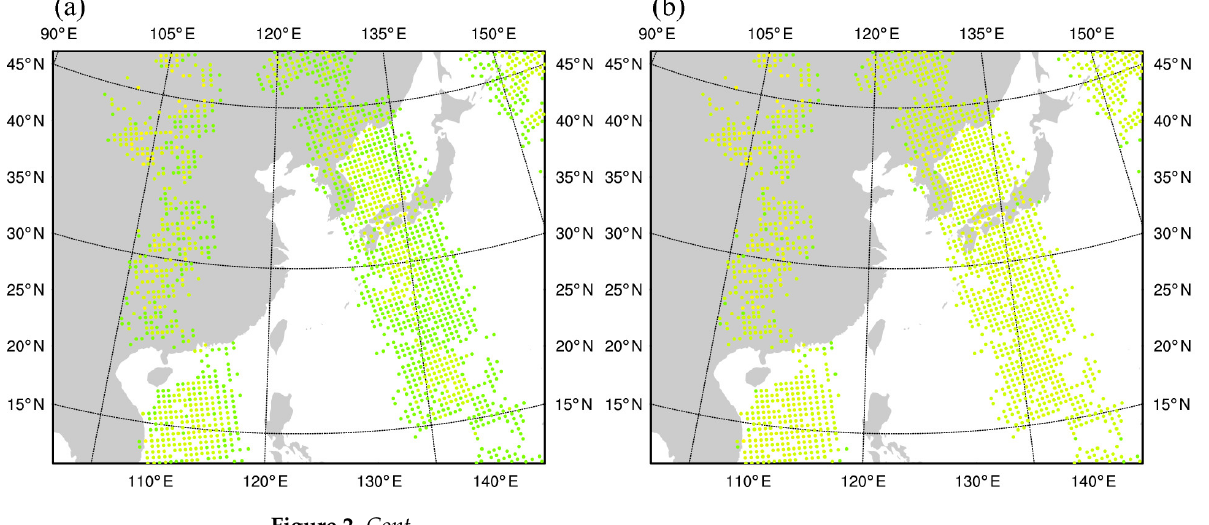
Figure 2. ( a , c , e ) OMB and ( b , d , f ) OMA after bias correction at 0600UTC on 22 July 2018, with NOAA-19 AMSUA channel 5 in the upper row, NOAA-19 MHS channel 4 in the middle row, and FY-3D MWHS2 channel 11 in the lower row.